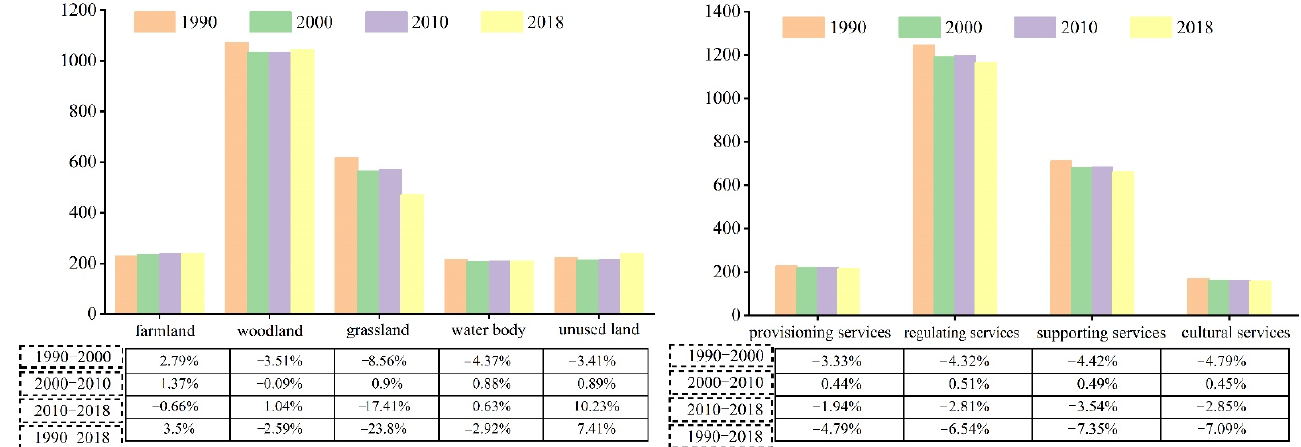
Figure 3. ESV and its change rate of different land use types in China from 1990 to